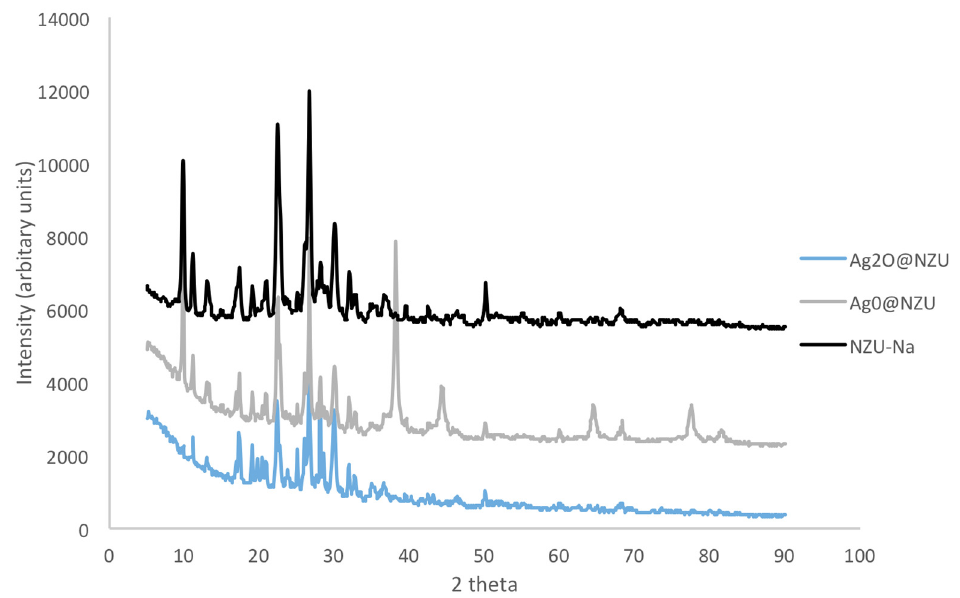
Figure 1. XRD patterns of Ag 0 @NZU, Ag 2 O@NZU and NZU ‐ Na.